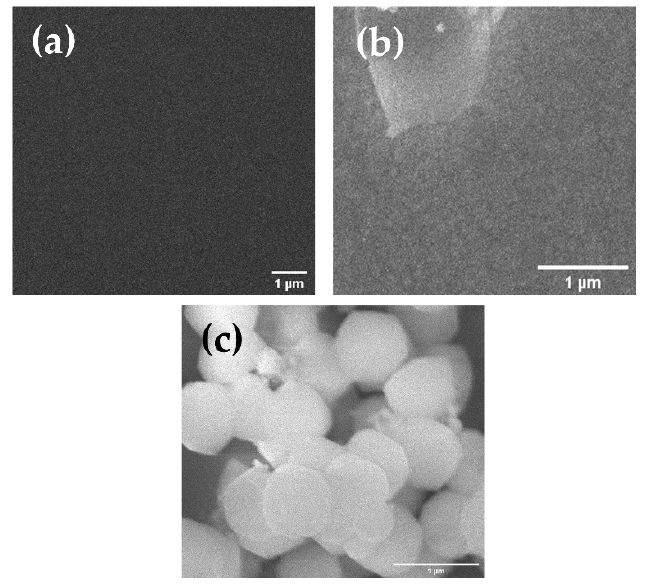
Figure 1. FESEM images for ( a ) bare ITO ( b ) PEDOT:PSS/ITO, and ( c ) ZIF-8 NPs/PEDOT:PSS/ITO. The topography of the bare ITO, PEDOT:PSS/ITO, and ZIF-8 NPs/PEDOT:PSS/ITO was examined by 2 dimensional AFM analysis in Figure 2a–c, respectively. The AFM image of bare ITO showed a vague microstructure with the root mean square (R.M.S.) surface roughness (R q ) 4.14 nm. The topology of the ITO substrate noticeably improved upon functionalization with PEDOT:PSS.